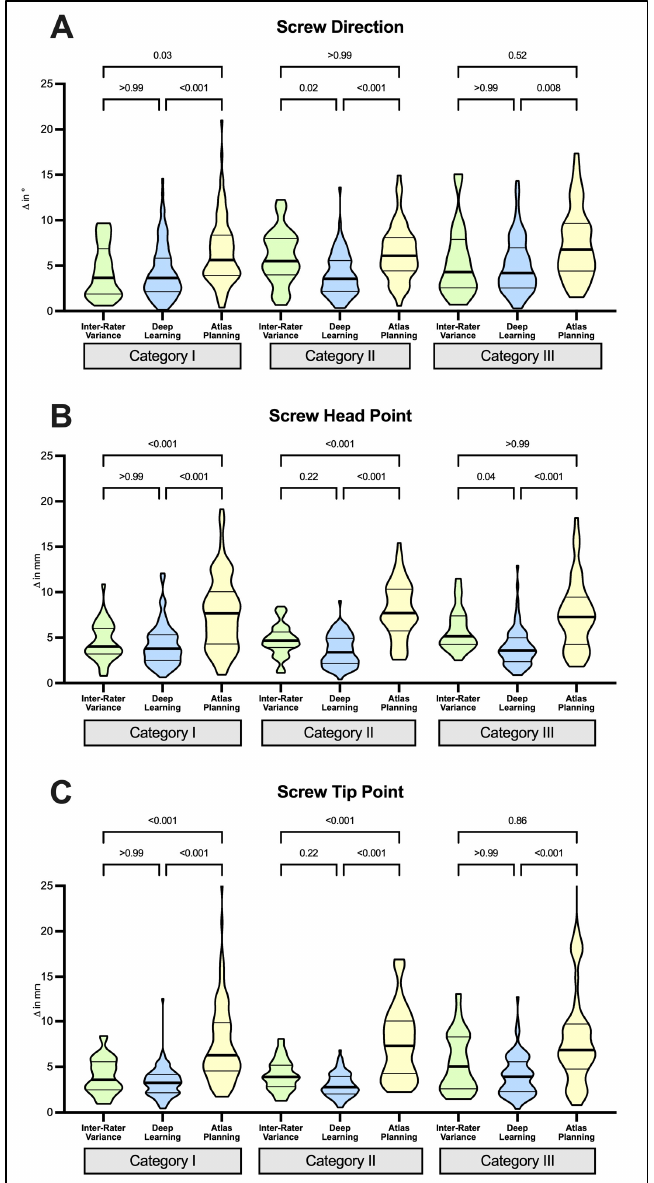
Figure 3. Comparison of screw planning results under consideration of the degree of alteration of vertebra anatomy and spinal alignment. Screw direction ( A ), screw head ( B ) and tip points ( C ) were used as benchmarks for comparison of mean absolute di ff erences between deep-learning- and atlas- based screws with their respective manually planned reference screws and interrater variance of manual screw planning. Categories I–III re fl ect subgroups of cases with increasing alterations to vertebra anatomy and spinal alignment. Note the reduced success in atlas-based planning (208/256 screws, 81%) available for analysis. Statistical signi fi cance was tested with Kruskal–Wallis tests followed by Dunn’s post-test for multiple comparisons.